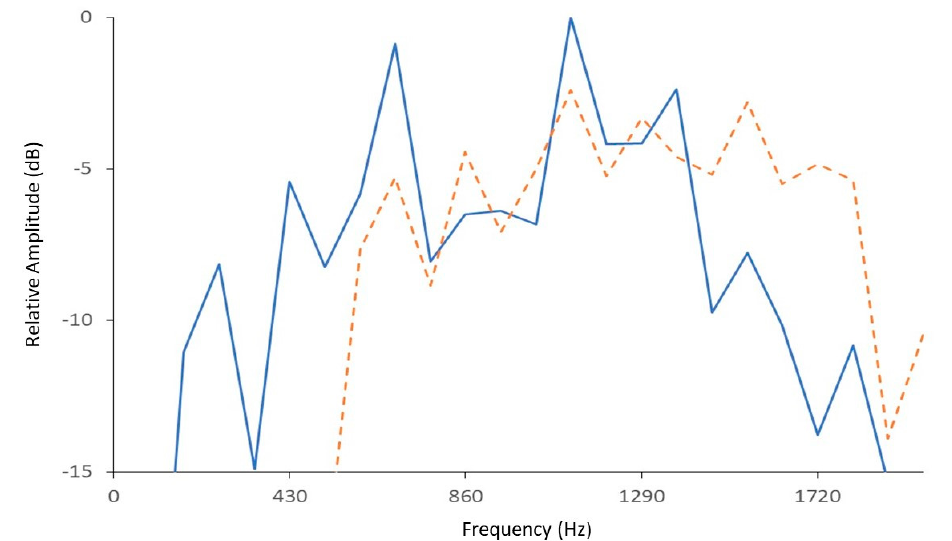
Figure 2. Profiles (mean spectra) of two representative vibrational calls (designated by solid and dashed lines) produced by D. citri on small citrus trees, recorded by methods described in Wenninger et al. [16]. The profiles were used to automate discrimination and counting of calls produced by D. citri in this study.